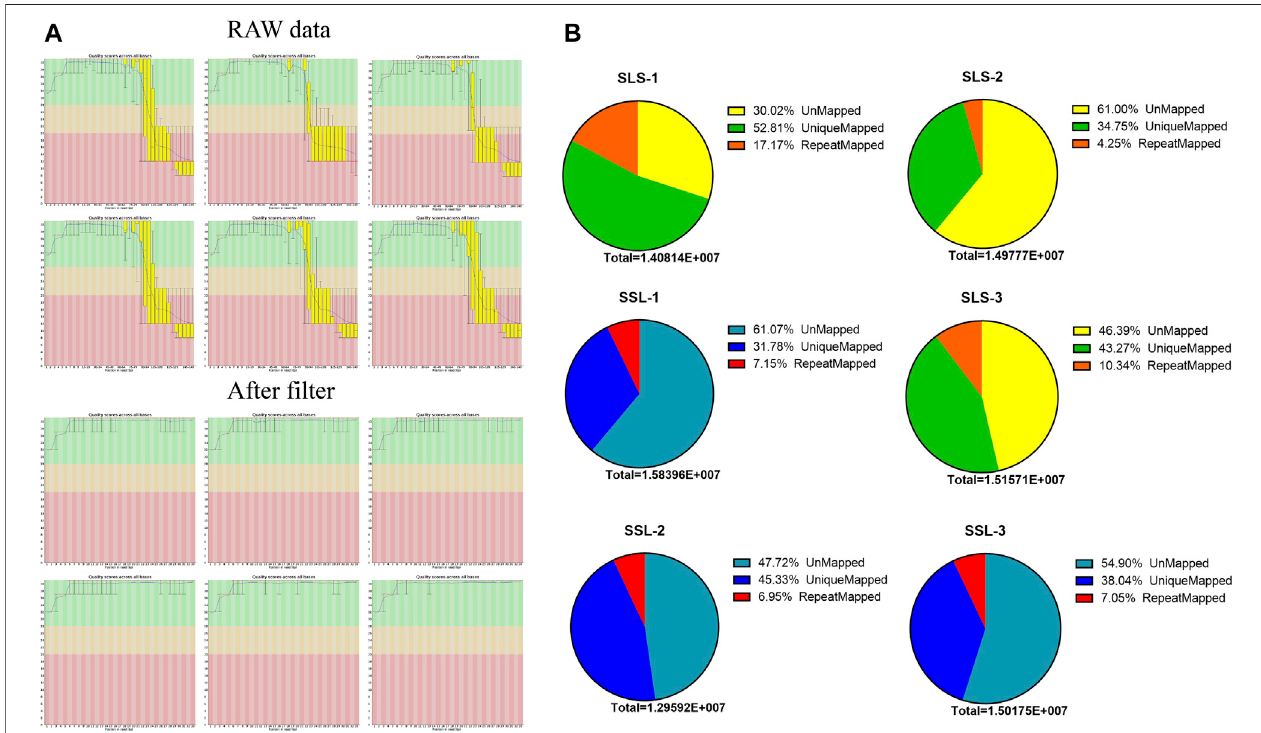
FIGURE1| MicroRNAdata fi lteringandmappingoftheswinegenome. (A) Dataqualitycontrol,throughthedatascoresand fi lteringlow-qualitydataofmicroRNA- seq for subsequent analysis. (B) The microRNA data mapped rates of high (LLS) and low (SLS) fertility swines ( n (cid:1) 3).